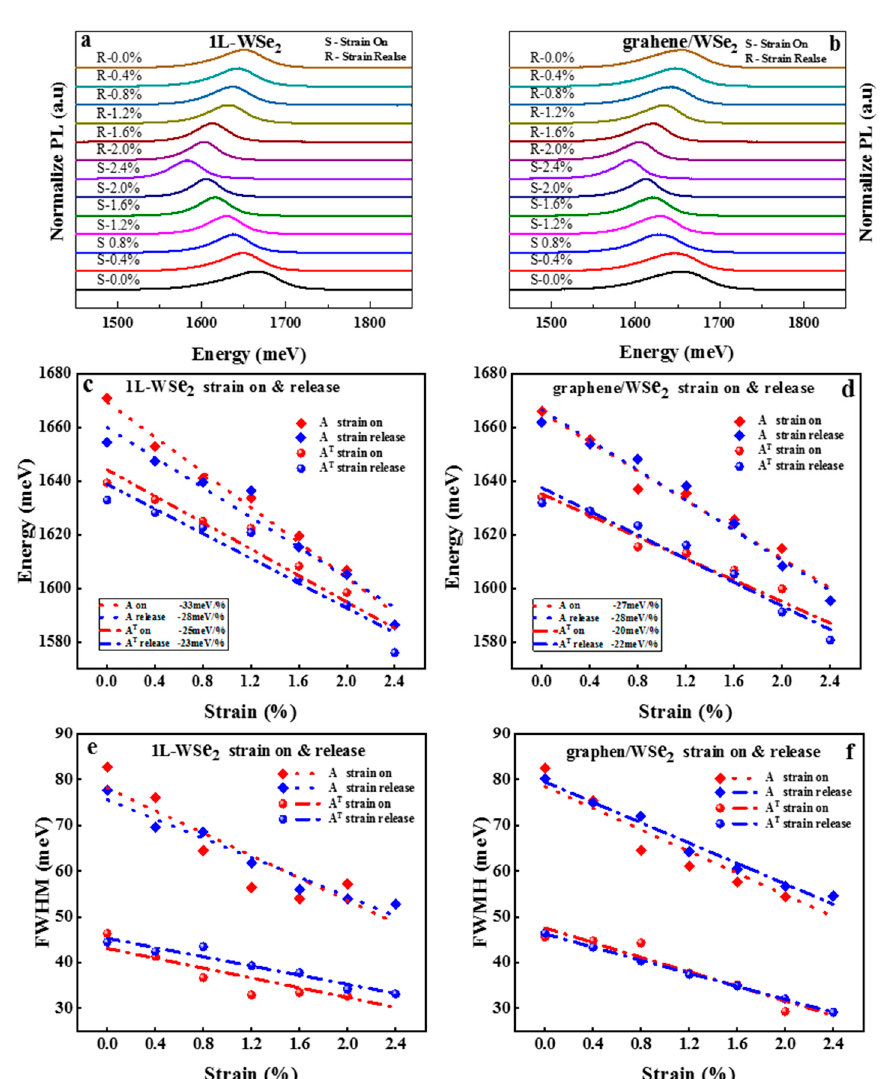
Figure 2. ( a ) PL spectra with strain on and release for 1L WSe 2 . ( b ) PL spectra with strain on and re-lease for graphene/WSe 2 heterostructure. ( c ) The fitted PL emission energies of A and A T peaks in 1L WSe 2 with the strain on and release process from 0 to 2.4%. ( d ) The fitted PL emission energies of A and A T peaks in graphene/WSe 2 heterostructure with the strain on and release process from 0 to 2.4%. ( e ) The fitted FWMH of A and A T peaks in 1L WSe 2 with the strain on and release process from 0 to 2.4%. ( f ) The fitted FWMH of A and A T peaks in graphene/WSe 2 with the strain on and release process from 0 to